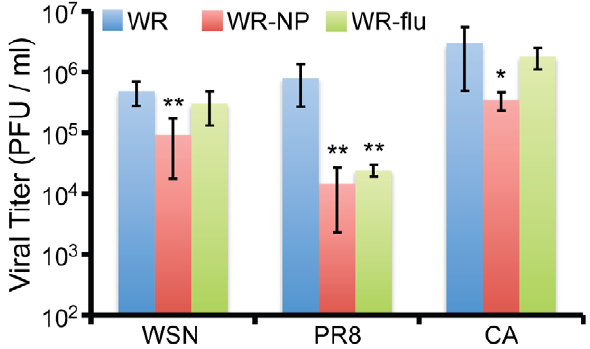
Figure 8. Vaccination reduces the levels of infectious virus in the lungs of influenza virus-challenged mice. Two weeks following the end of the vaccination protocol, mice from each vaccination group were infected with 10 6 LD 50 of the A/WSN/33 (WSN), A/PR/8/34 (PR8), or A/California/07/09 (CA) strains of influenza virus. Mice were sacrificed at 5 d p.i. (except for some mice challenged with CA that died at 3–4 d p.i), and diaphragmatic lung lobes were isolated and homogenized. Levels of infectious virus were determined in triplicate by plaque assay on MDCK cells. The results represent the mean activity of 5–8 independent samples per group 6 standard deviation. P values from a two-tailed t test assuming nonequal variance are indicated (*, P , 0.05; **, P ,